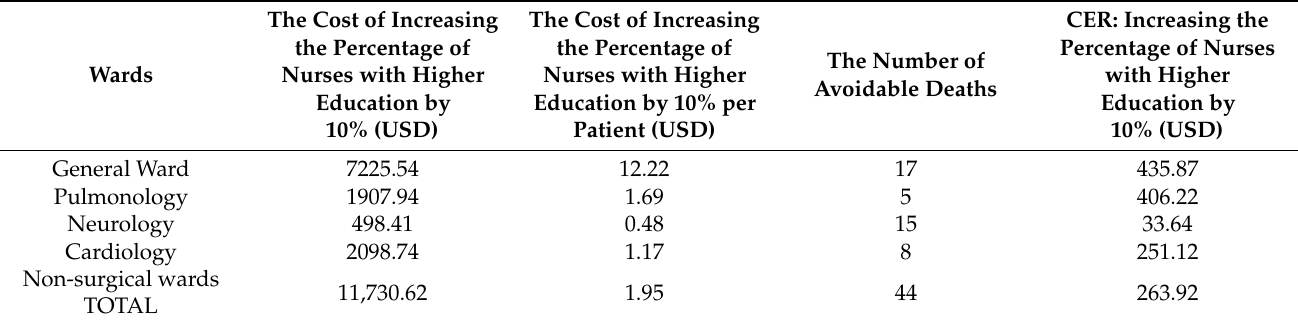
Table 4. The cost of additional interventions per patient and the cost-effect ratio (CER) of avoidable